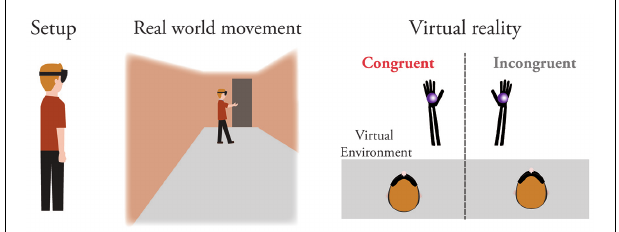
FIGURE 1 | Experimental setup and virtual environment. Participants wear a head-mounted display with a sensor that tracks both hands. They can move freely within the room, using their hands to play with a virtual ball (right hand in the figure). In virtual reality, the avatar hands can be congruent with the real hands or switched and incongruent. The figure on the right shows the virtual display of a participant’s right arm in congruent and incongruent conditions. In each experimental condition, both hands were either congruent or